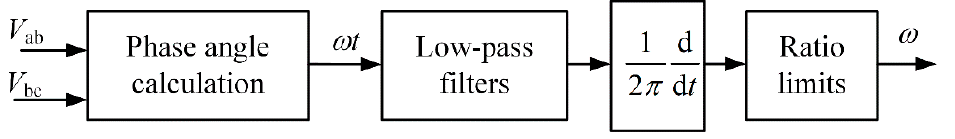
Figure 6. Instantaneous PLL.